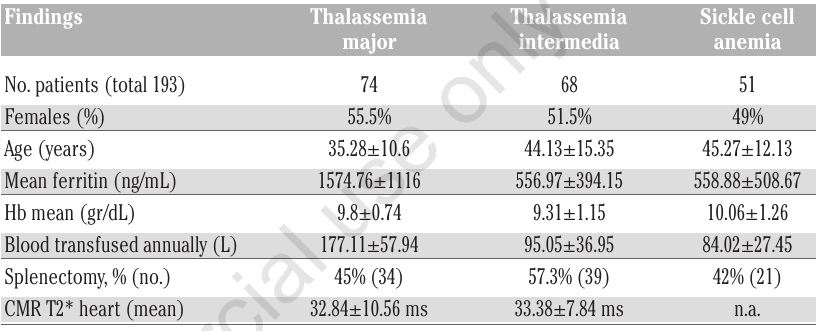
Table 1. Clinical, laboratory and instrumental data of the patients studied.